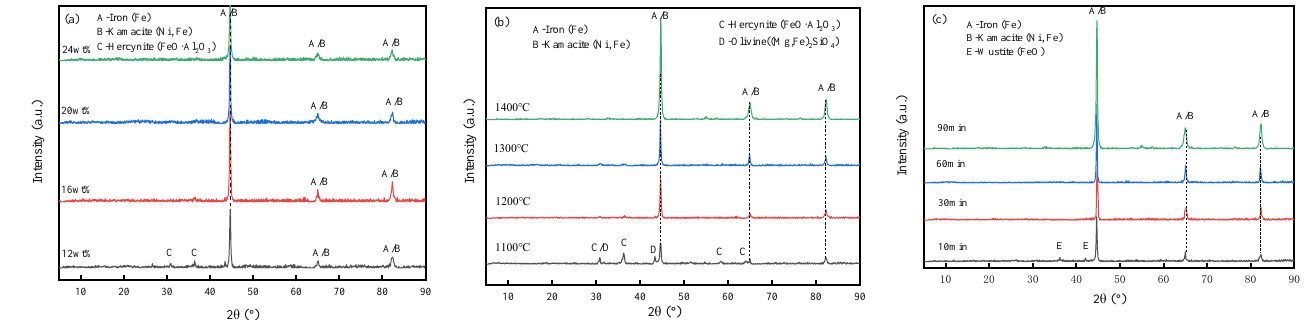
Figure 9. XRD patterns of reduction products: ( a ) different anthracite dosage, reduction temperature of 1200 °C, reduction time of 90 min; ( b ) different reduction temperature, anthracite of 16 wt%, reduction time of 90 min; ( c ) different reduction time, anthracite of 16 wt%, reduction temperature of 1400 °C.